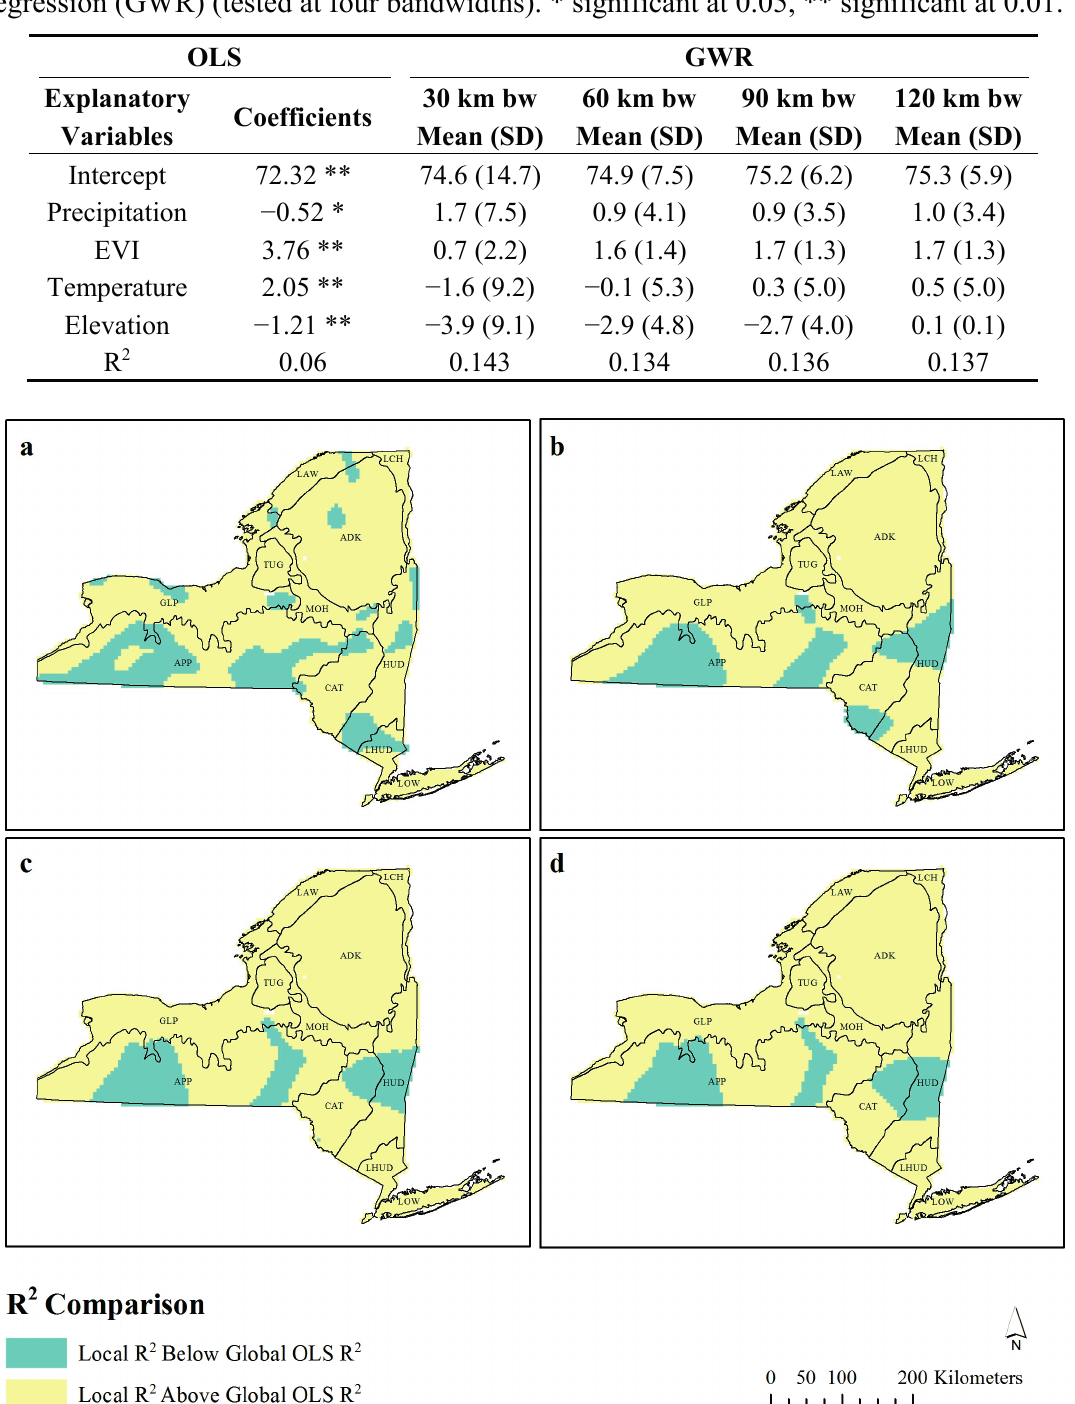
Figure 2. Local R 2 values for each observation compared to the global ordinary least squares (OLS) R 2 at bandwidths ( a ) 30 km, ( b ) 60 km, ( c ) 90 km, and ( d ) 120